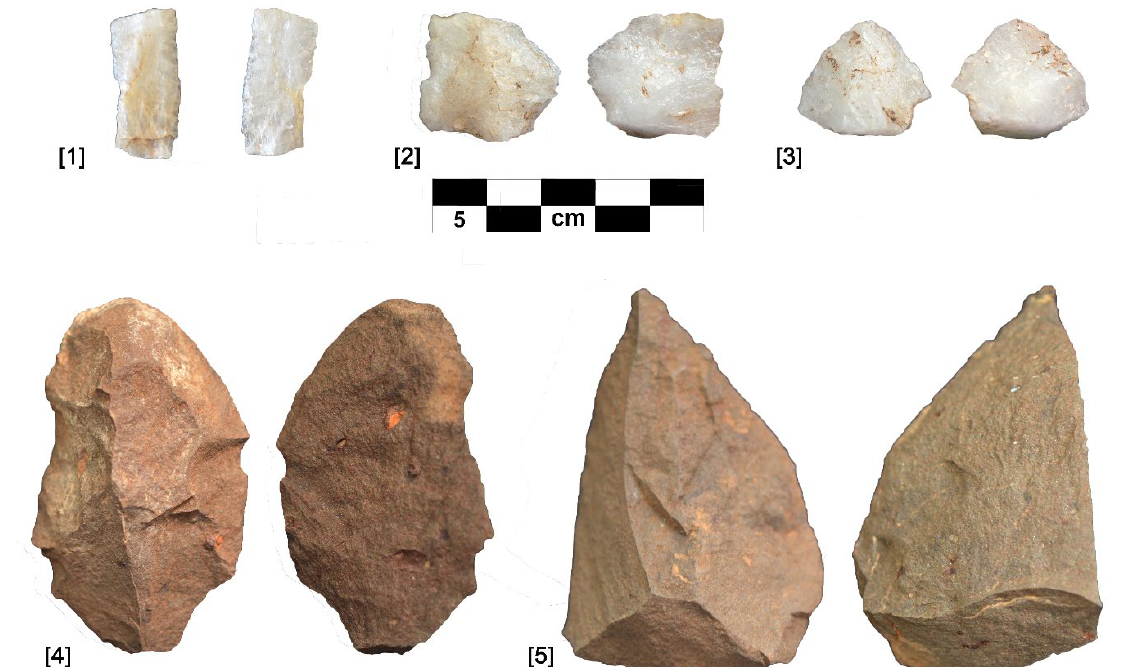
Figure 5. Débitage flakes in quartz (top) and basalt (base): [1] quartz bladelet; [2,3] quartz Levallois flakes; [4] basalt cortical flake; [5] basalt point.